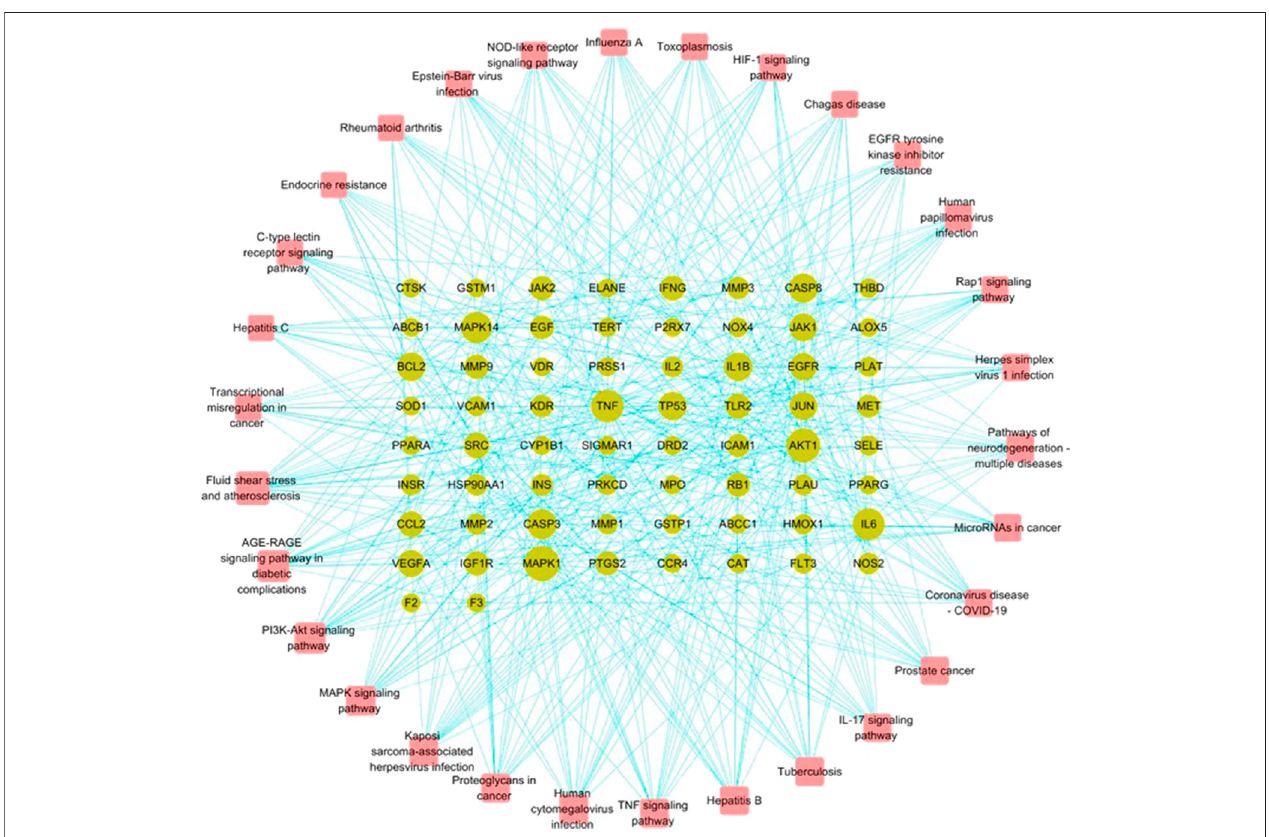
FIGURE 7 | Main component action target pathway enrichment network of H. cordata